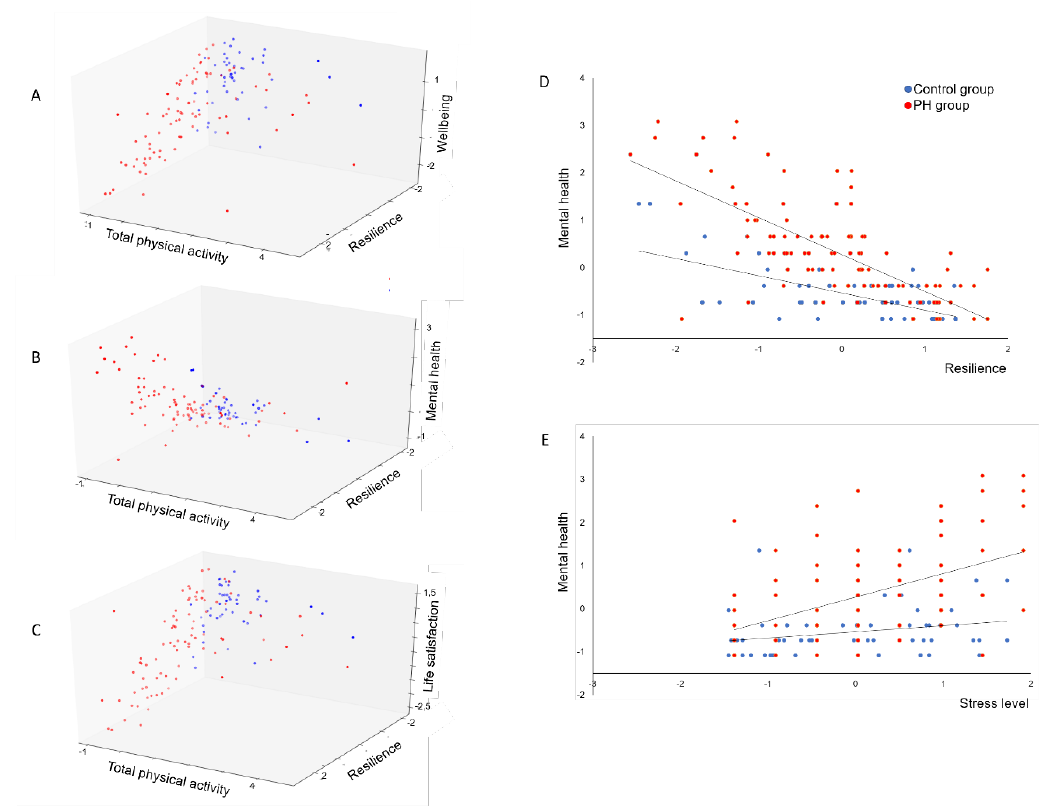
Figure 2. Associations between mental health dimensions, daily activity, and resilience for PH and control group. ( A ): Association between total physical activity, resilience, and wellbeing for PH and control group. ( B ): Association between total physical activity, resilience, and mental health for PH and control group. ( C ): Association between total physical activity, resilience, and life satisfaction for PH and control group. ( D ): Association between resilience and mental health for PH and control group. ( E ): Association between stress and mental health for PH and control group.